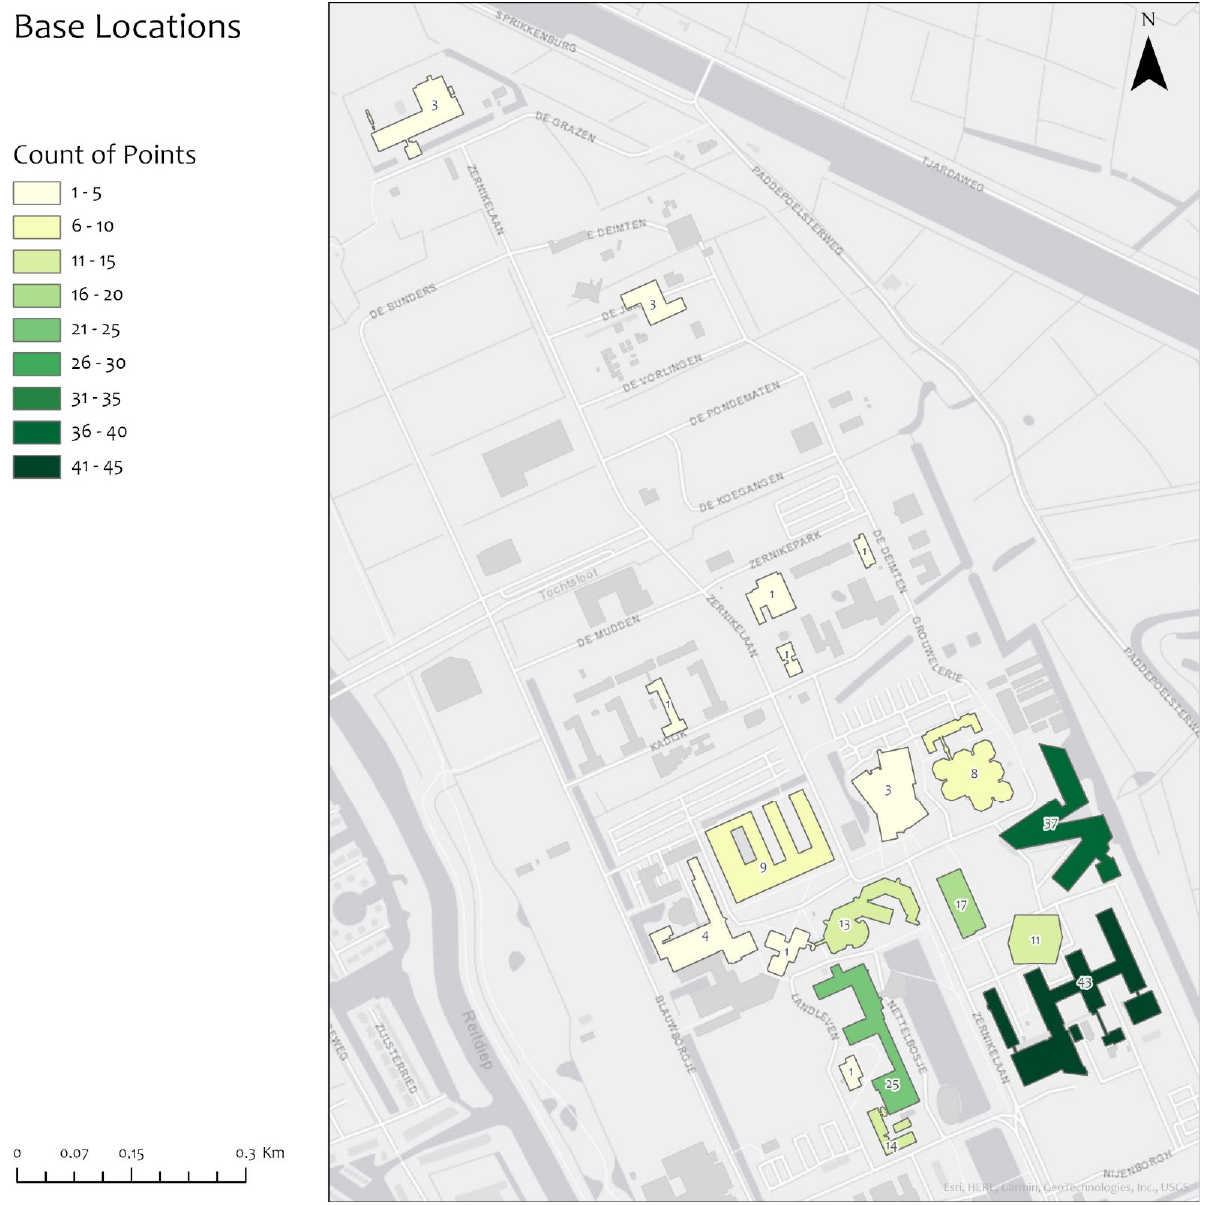
Figure A4. RUG campus—number of base locations.